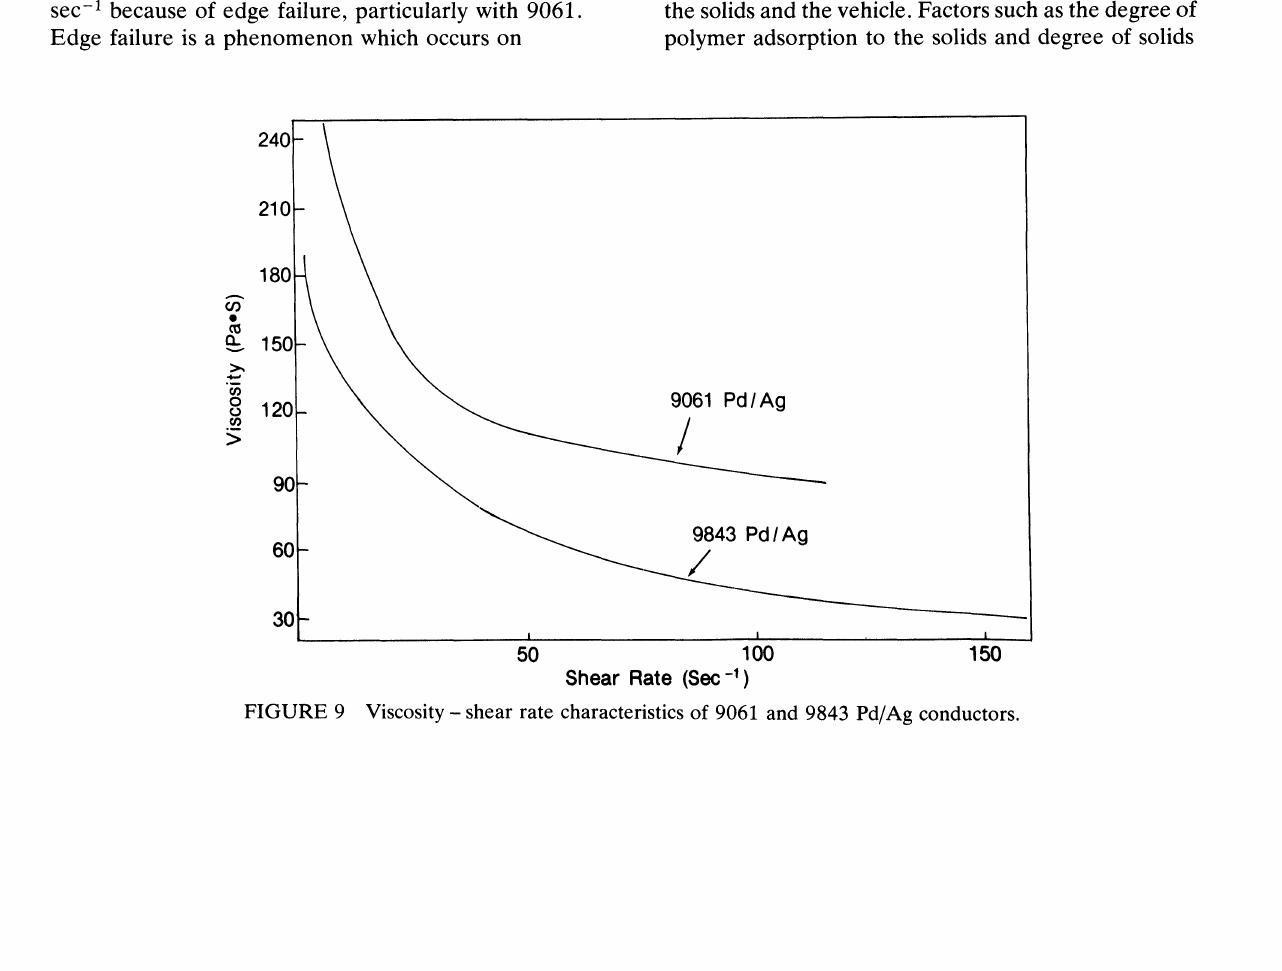
FIGURE 9 Viscosity- shear rate characteristics of 9061 and 9843 Pd/Ag